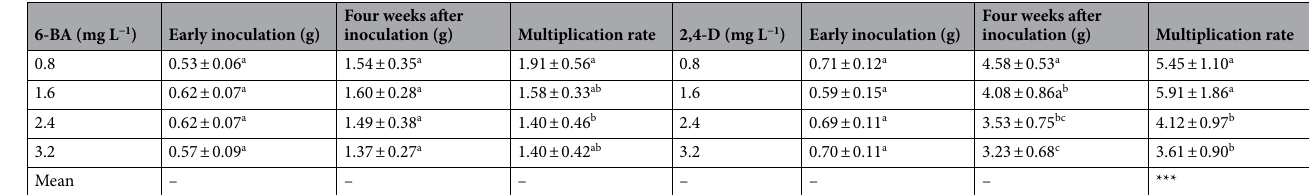
Table 5. Effect of different concentrations of 6-BA and 2,4-D on EC proliferation. Bars denote by the same letter within response variables are not significantly different ( P < 0.05) using Duncan’ s multiple range test. The results are significantly different ( P < 0.01) denoted with ***by Paired t